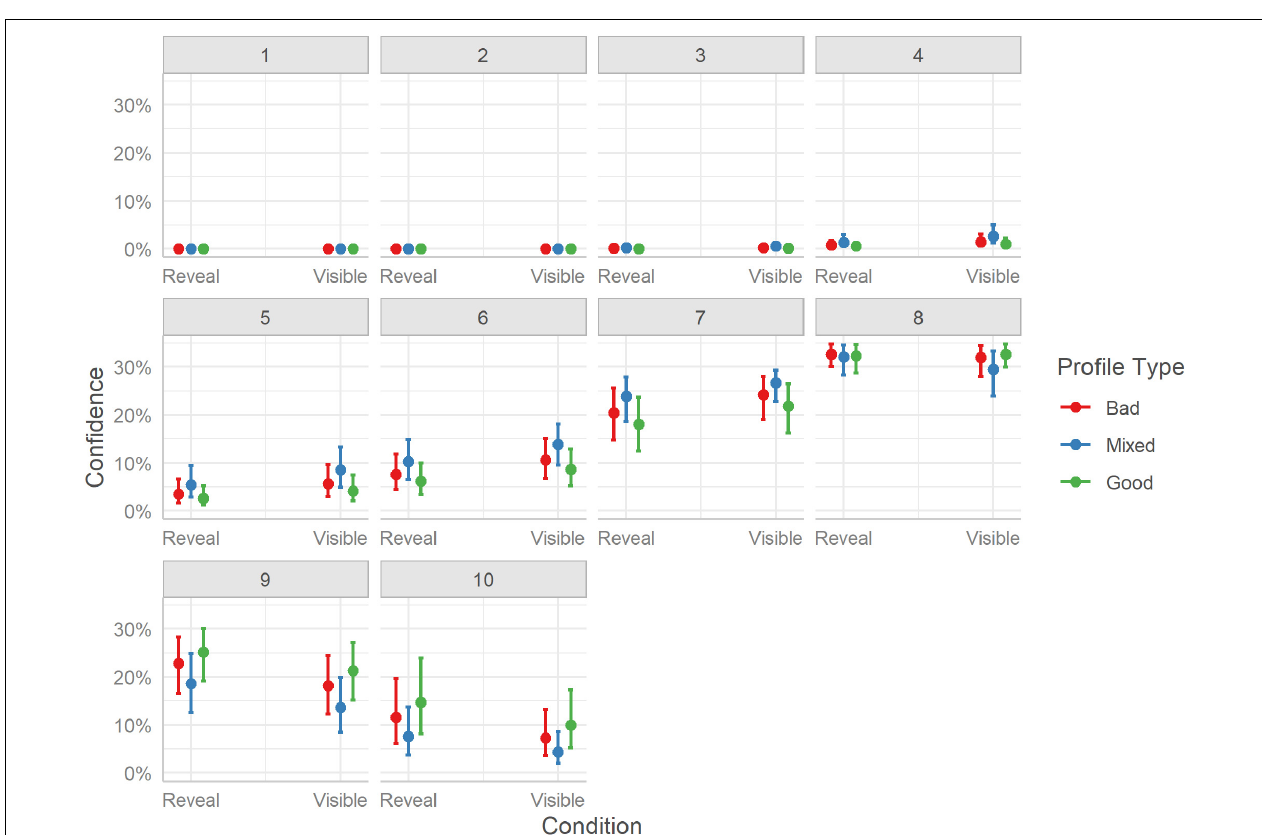
FIGURE 5 | Marginal effects of judgment confidence for profile classification. The posterior mean estimates of the probability of responses in each of the three Profiles (Bad, Good, Mixed) by the two experimental Conditions (Reveal or Visible). Error bars indicate 95% credible intervals.